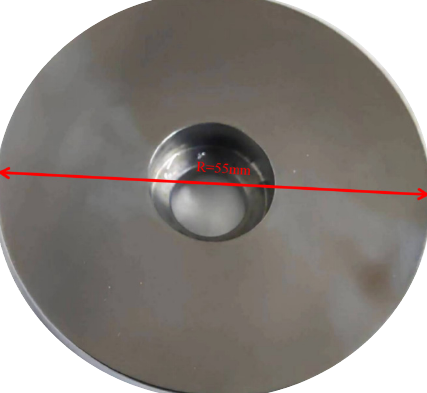
Figure 3. Physical diagram of the structure of the disc specimen.